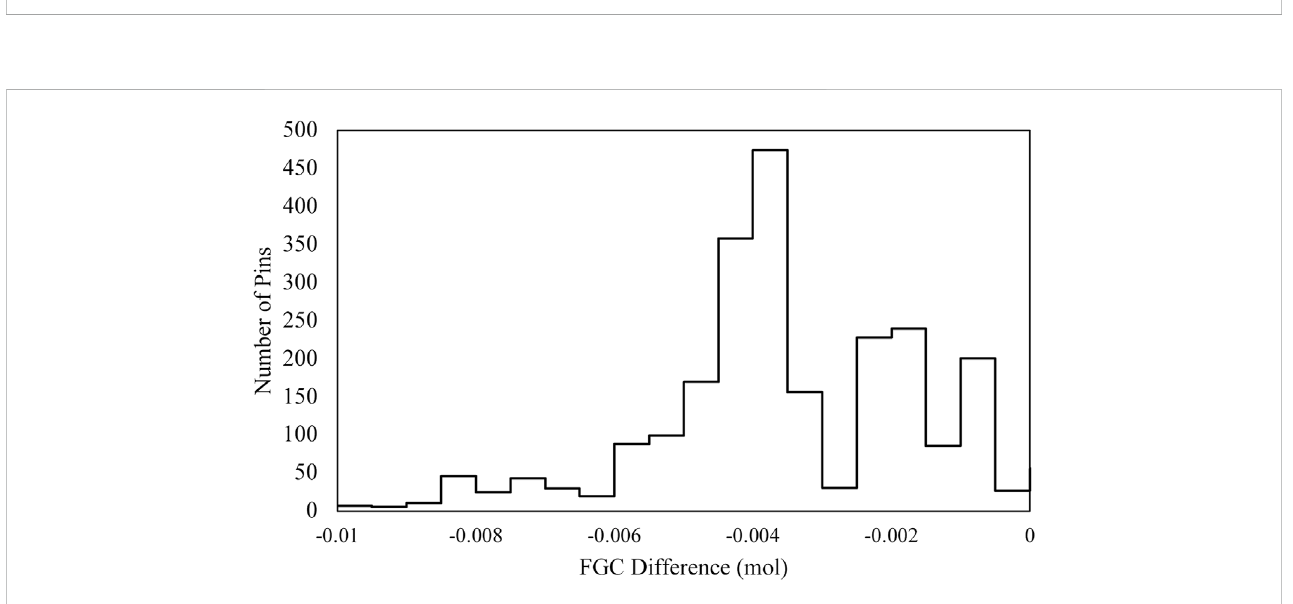
HFEF. Values for the fi ssion gas produced (FGP), fi ssion gas collected (FGC), and FGR fraction predicted from BISON results were compared to the 81 PIE measurements. Other pins used correlations within the IMIS database from these 81 measured pins to estimate FGP, FGC, and FGR percent for other EBR-II fuel pins not selected for measurements. Comparison of these parameters (IMIS estimated vs. BISON predictions) are shown in Figures 4 – 6. FGC is measured by puncturing the cladding and measuring the pressure differential in a controlled volume. Using the ideal gas law and the temperate of the hot cell, the total number of moles from fi ssion gas production was calculated. Of the fi ssion gas collected, the amount of fi ssion gas produced (including gas still contained within the fuel), is determined by analyzing the number of krypton gas moles released into the controlled volume, and assuming 25% of the fi ssion gas is